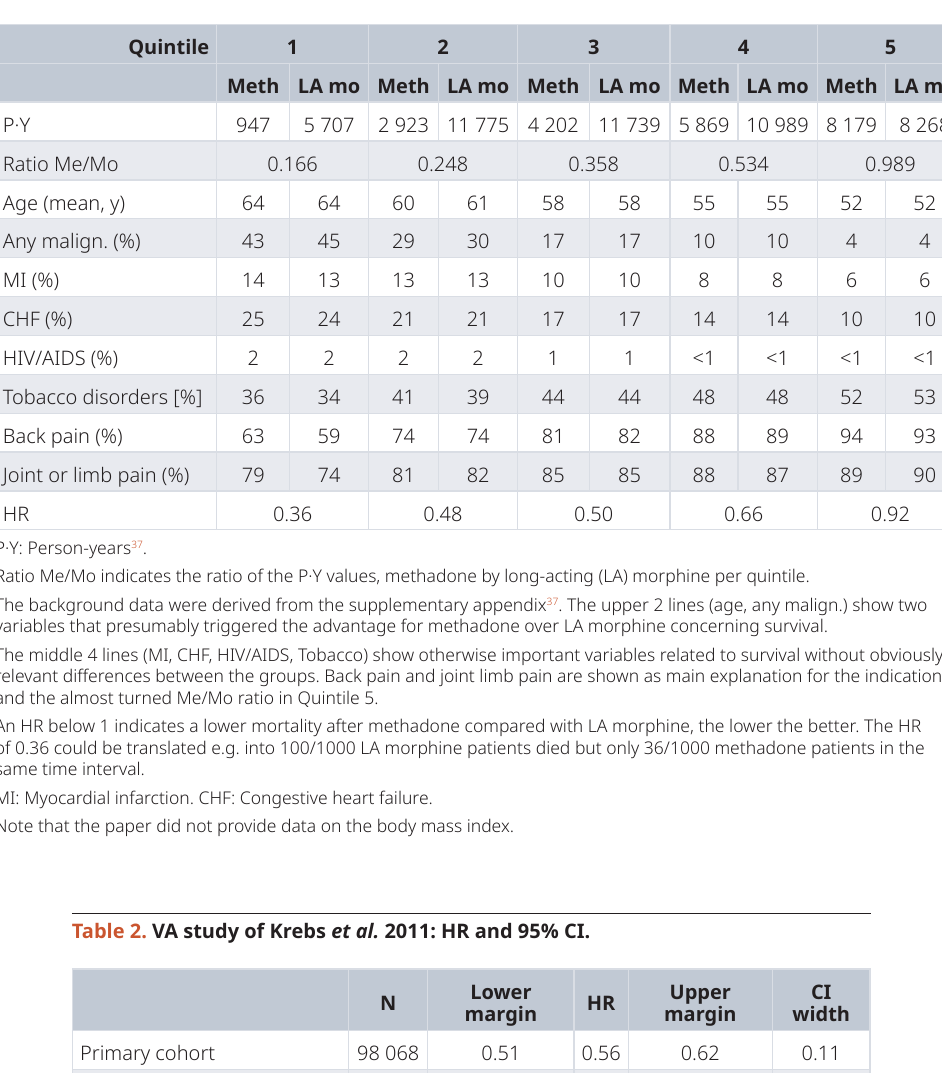
Table 1. VA study of Krebs et al. 2011: Main data of the propensity quintiles. Quintile